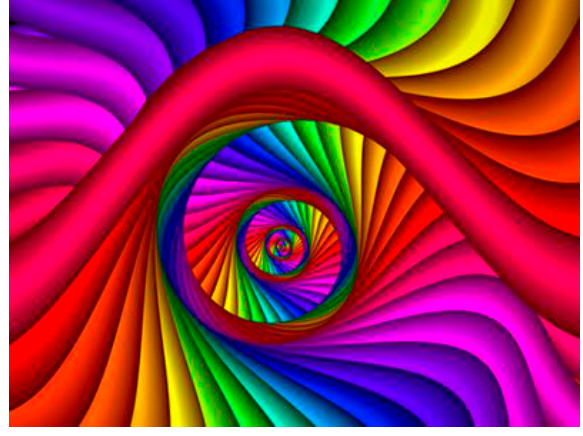
Figure 13. Test color image.